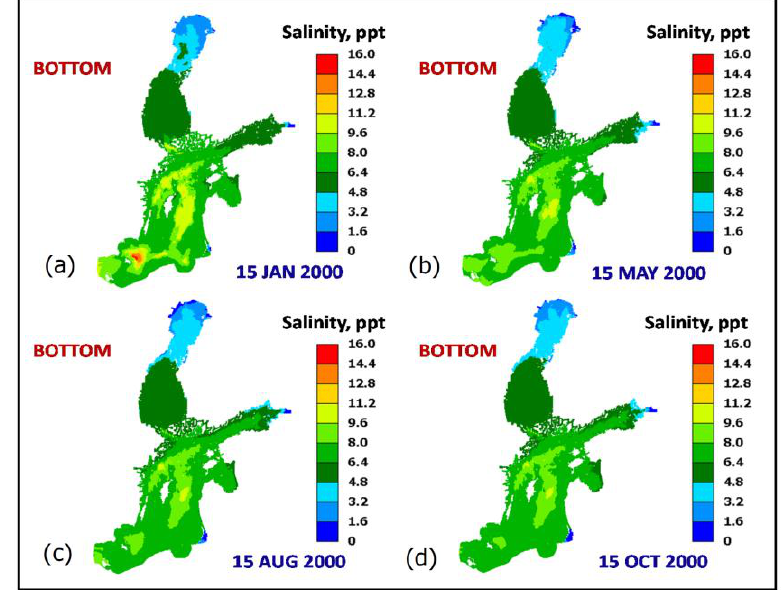
Figure 16. Seasonal plots of bottom salinity in the Baltic Sea for the year 2000. ( a ) Winter; ( b ) Spring; ( c ) Summer; ( d ) Autumn.